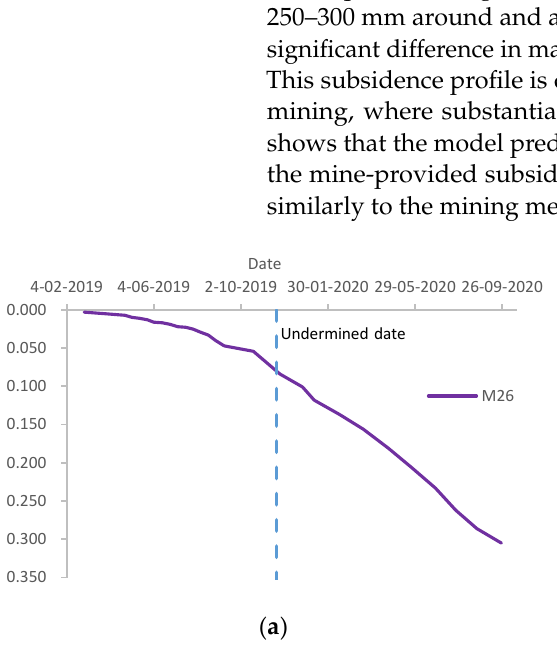
Figure 3. ( a ) Mine observed subsidence along the panel length during its excavation between May 2019 and September 2020; ( b ) modelled subsidence along the panel length.